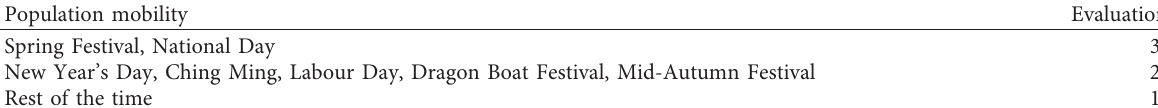
Table 6: Numerical table of population mobility.